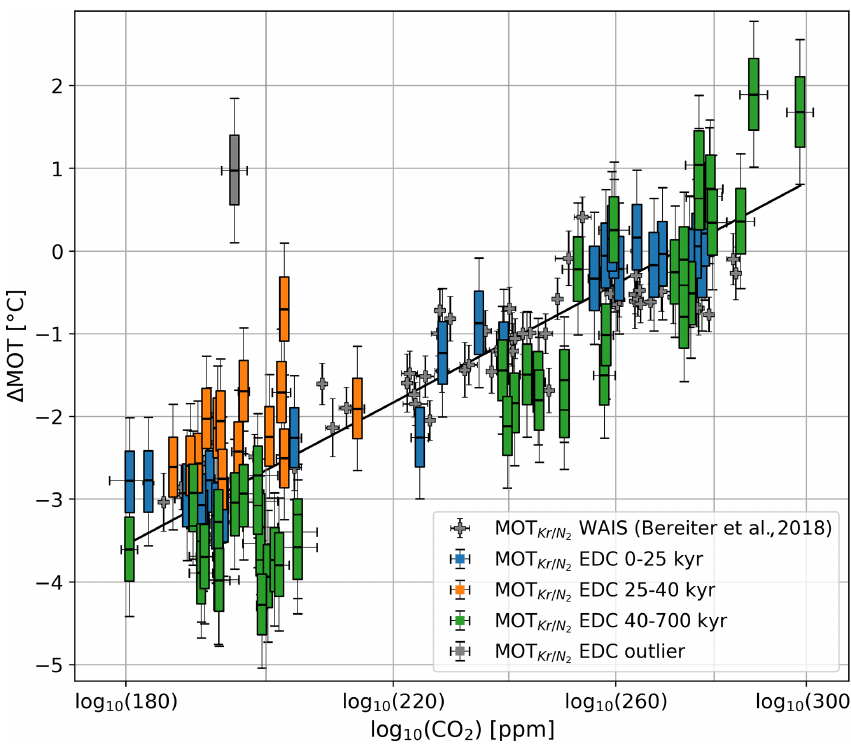
Figure 10. Scatter plot showing a linear relationship between logarithmic CO 2 (values taken from Bereiter et al., 2015) and the MOT relative to the Holocene. MOT reconstructions are based on Kr / N 2 and corrected for thermal, gravitational, and HID fractionation. MOTs from the last 25kyr are shown in blue, samples from 25–40kyrBP are shown in orange, and samples from 120 to 700kyrBP are in green. The linear regression (black line) is based on EDC data only and has an r 2 of 0.75. Given in grey is the MOT reconstruction over the last 22kyr from Bereiter et al. (2018b) relative to the